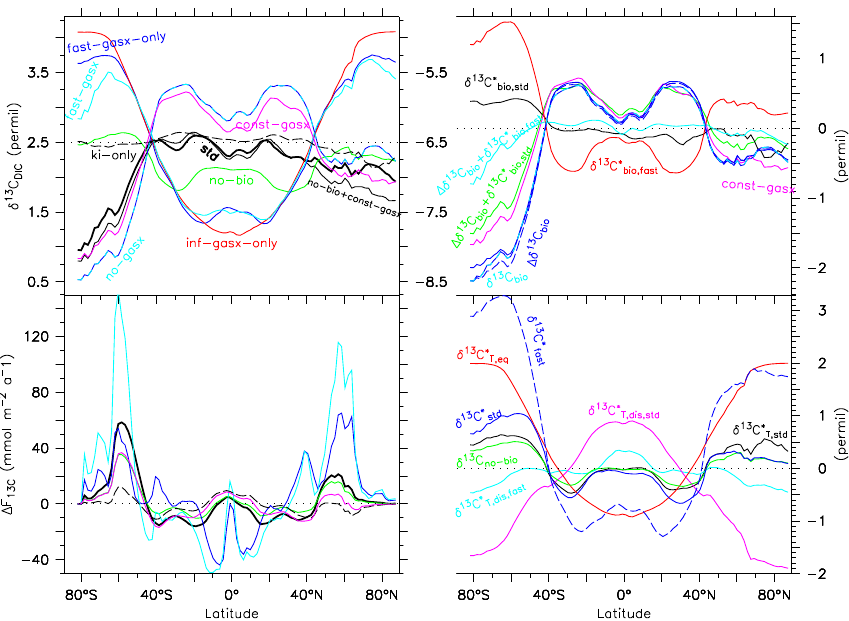
Fig. 4. Left panels: zonally averaged preindustrial surface δ 13 C DIC (top) and 1F 13 (bottom) as a function of latitude for model C std (thick black) and some of the sensitivity experiments listed in Table 1. Experiments const-gasx and ki-only use the right axis, all other experiments the left axis. The sparsely dotted line indicates the value of atmospheric δ 13 C A = − 6 . 5‰ (right axis). The curve for experiment bio-fast is identical to that of fast-gasx . The red curve labeled inf-gasx-only represents the equilibrium fraction- ation for infinitely fast gas exchange and has been calculated as described in the text. The thin black line has been calculated as δ 13 C DIC , no-bio + δ 13 C DIC , const-gasx + 6 . 5‰ and its difference with std indicates errors in the factorial analysis due to non-linearities. Right panels: effects of biological fractionation and air–sea gas exchange on surface δ 13 C DIC calculated using Eqs. (27)–(31). Top: 1δ 13 C bio (blue) from the standard model (Eq. 20, solid) and from model bio-fast (dashed), estimates of 1δ 13 C bio + δ 13 C ∗ from bio , std δ 13 C DIC , const-gasx (purple) and from the difference δ 13 C DIC , std − δ 13 C DIC , no-bio (green), 1δ 13 C bio + δ 13 C ∗ estimated from the dif- bio , fast ference δ 13 C DIC , bio-fast − δ 13 C DIC , fast-gasx-only (light blue), δ 13 C ∗ estimated from δ 13 C const-gasx − δ 13 C no-gasx (black; mean sub- bio , std tracted), δ 13 C ∗ calculated from δ 13 C DIC , bio-fast − δ 13 C DIC , fast-gasx-only − 1δ 13 C bio (red). Bottom: δ 13 C ∗ (blue solid, Eq. 19), δ 13 C ∗ bio , fast std fast ∗ ∗ 13 C ∗ 13 C = δ 13 C + δ 13 C (blue dashed), δ 13 C DIC , inf-gasx-only (red; mean subtracted), δ DIC , no-bio (green) and T, eq T, eq T, dis , std estimated from δ ∗ ∗ 13 C − δ 13 C δ 13 C DIC , std − δ 13 C DIC , const-gasx (black; mean subtracted), δ 13 C DIC , fast-gasx-only T, dis , fast estimated from δ T, eq (light blue), and ∗ ∗ 13 C − δ 13 C δ 13 C DIC , no-bio T, dis , std estimated from δ T, eq (purple). Vertical axes for the upper panels have the same